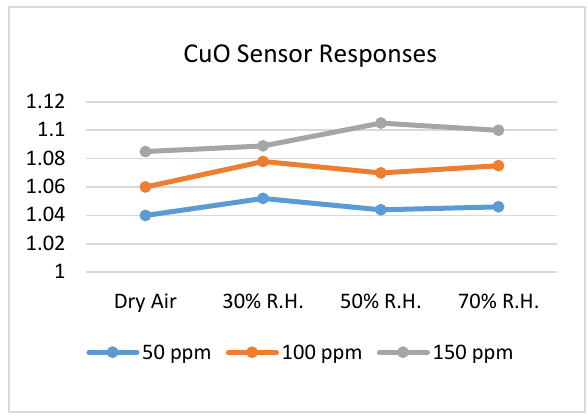
Figure 22. CuO sensor response for different humid levels and concentration levels at 325 °C.